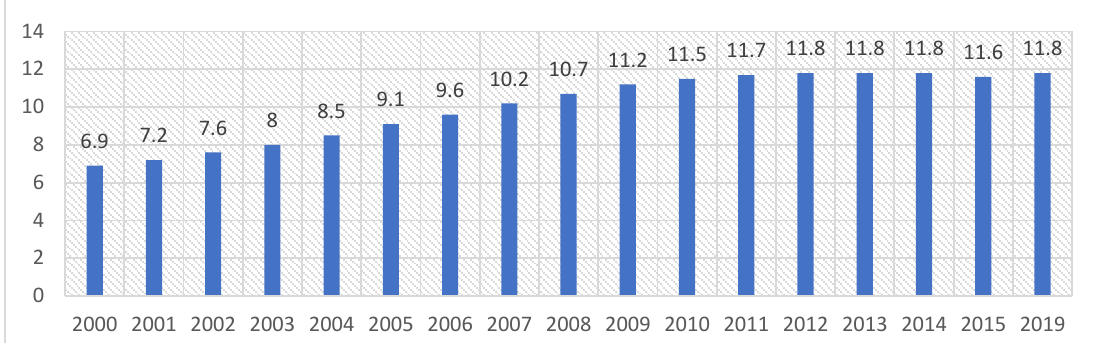
Trends in the prevalence (%) of low birth weight (<2500 g) (2000-2019)